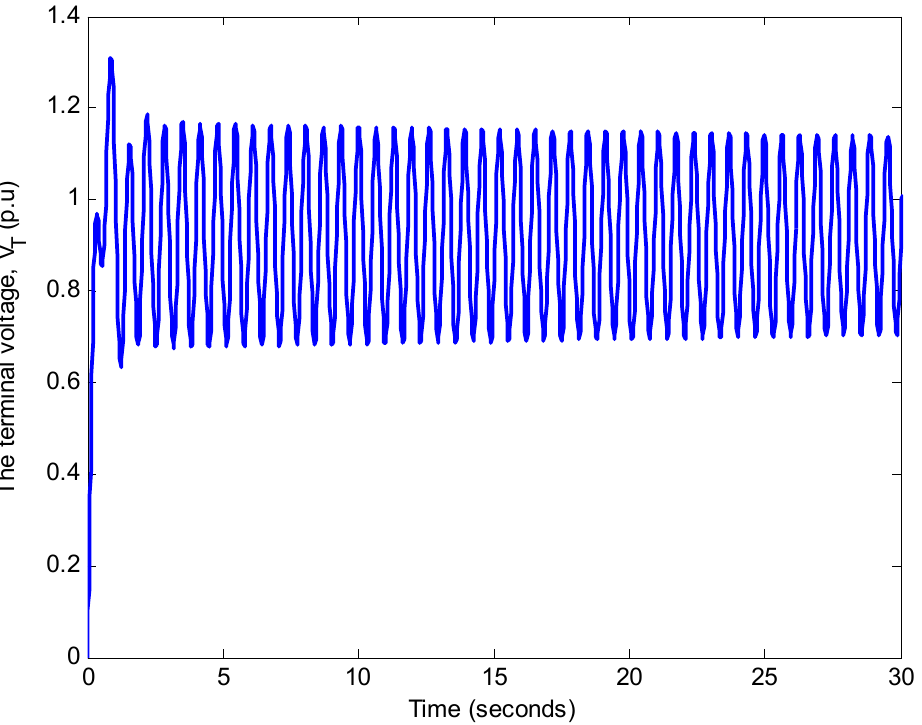
Figure 17. The terminal voltage with a 0.1632 s time delay.